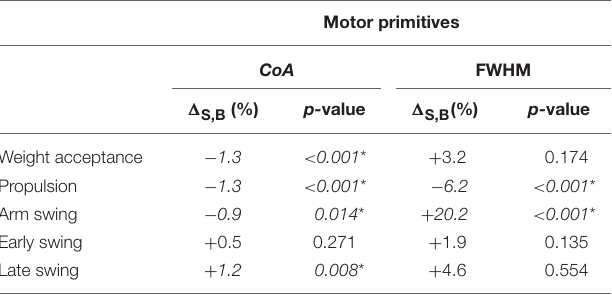
TABLE 3 | Differences between shod and barefoot running in the center of activity ( CoA ) as well as in the relative full width at half maximum (FWHM) of motor